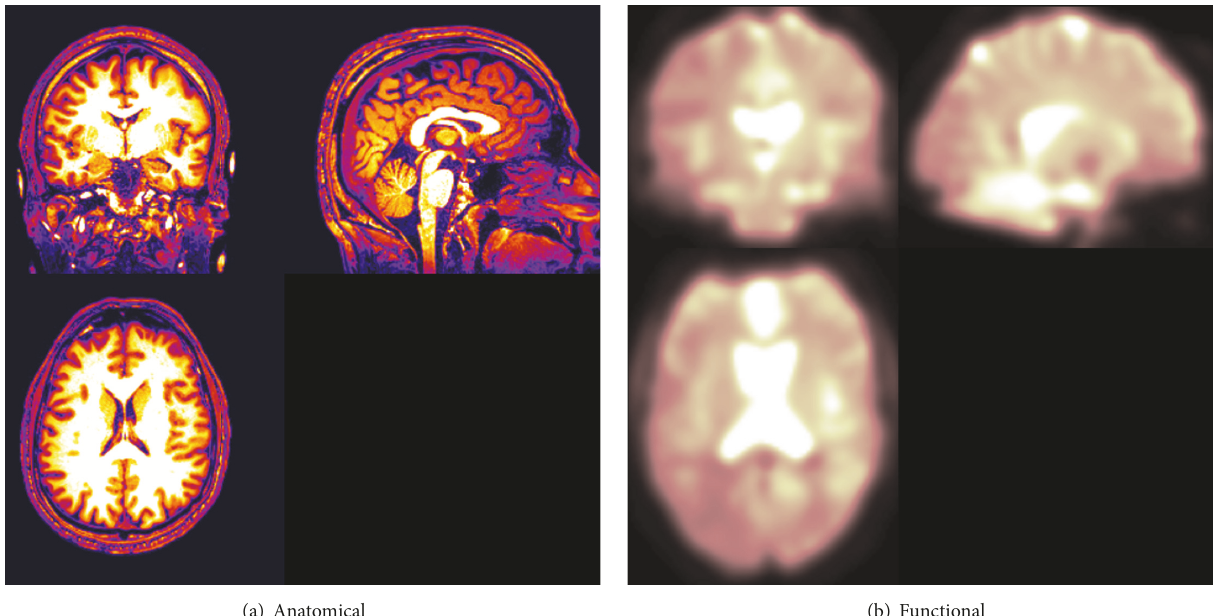
Figure 1: Anatomical and functional slices of the